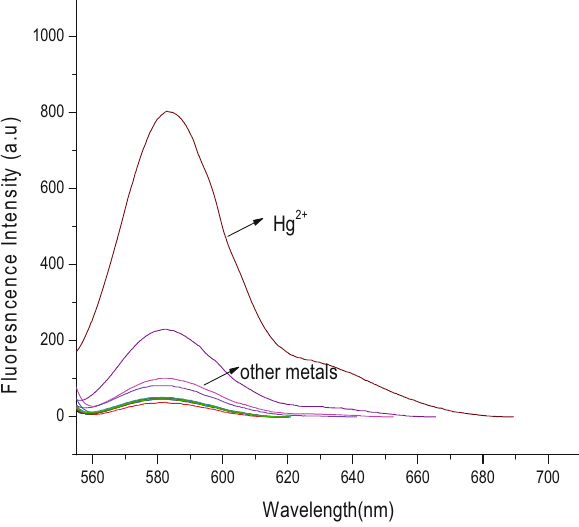
Figure 4: Fluorescence spectrum of di ff erent metal ions and rhoda - mine class B derivatives response ( CH 3 CH 2 OH/H 2 O [ v/v, 1/2 ] , λ = 530 nm, probe concentration 10 × 10 − 5 mol · L − 1 , metal ions ex concentration 10 × 10 − 5 mol · L − 1 )